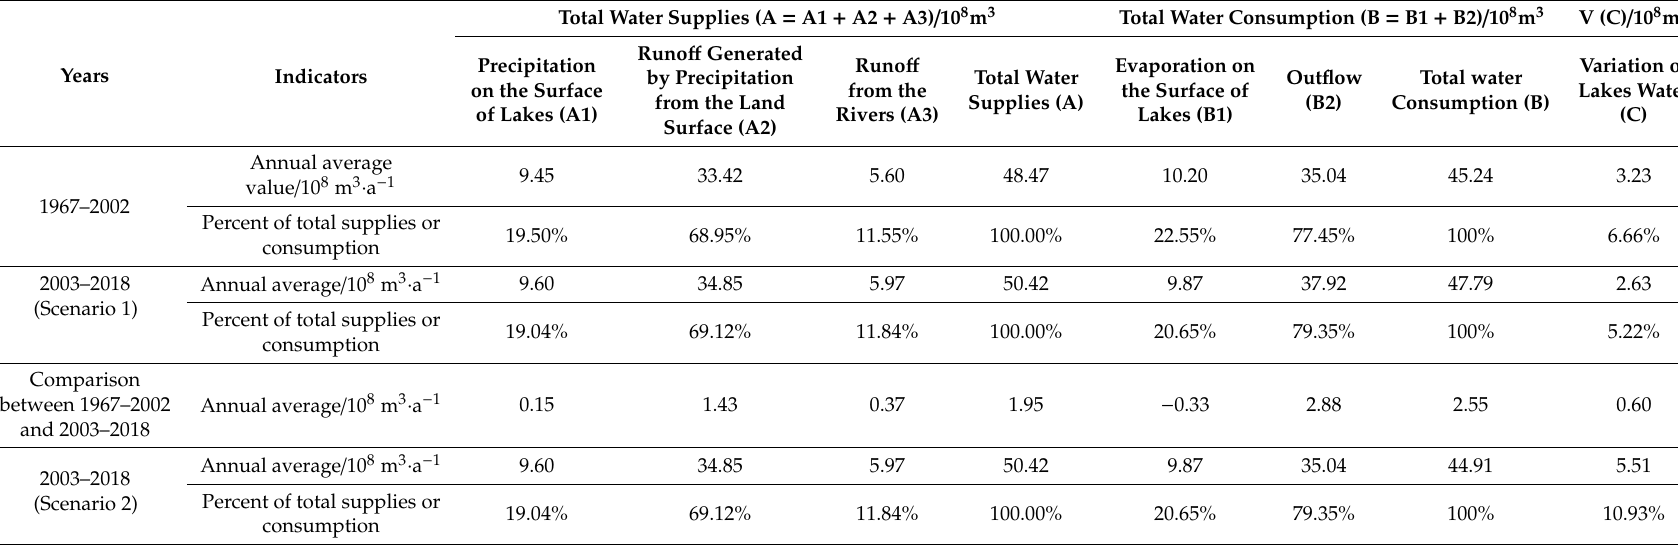
Table 1. Comparison of water supply and consumption in Huayang Lakes during the study